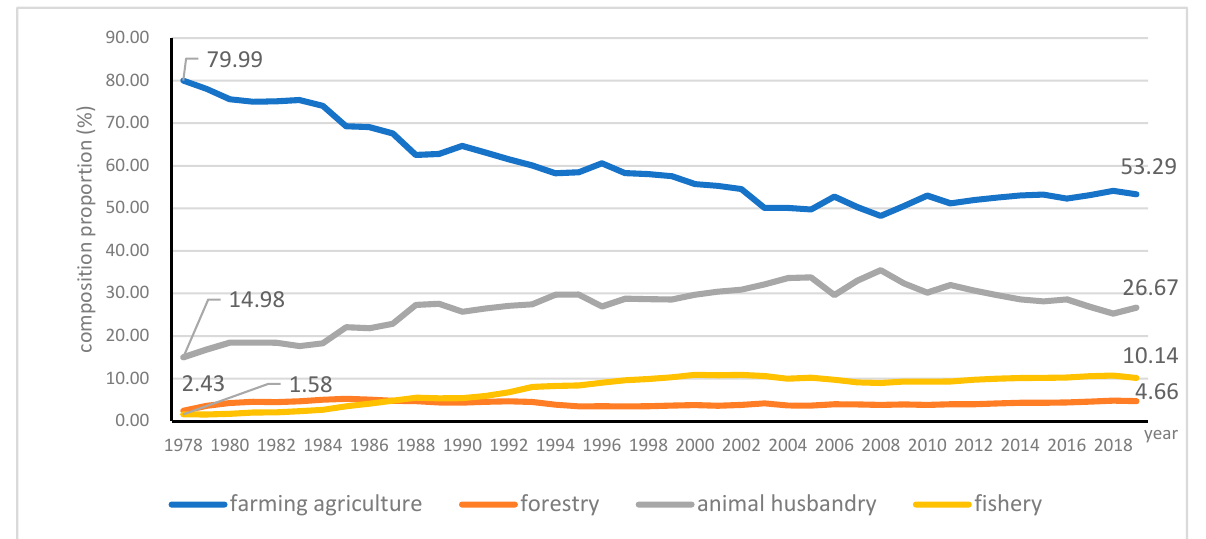
Figure 7. The composition of agricultural sectors.